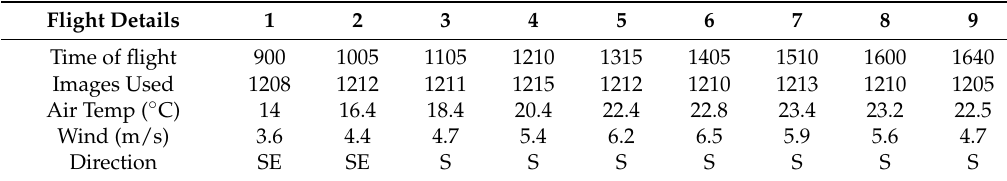
Table 2. Flight characteristics and meteorological conditions for 31 January 2017